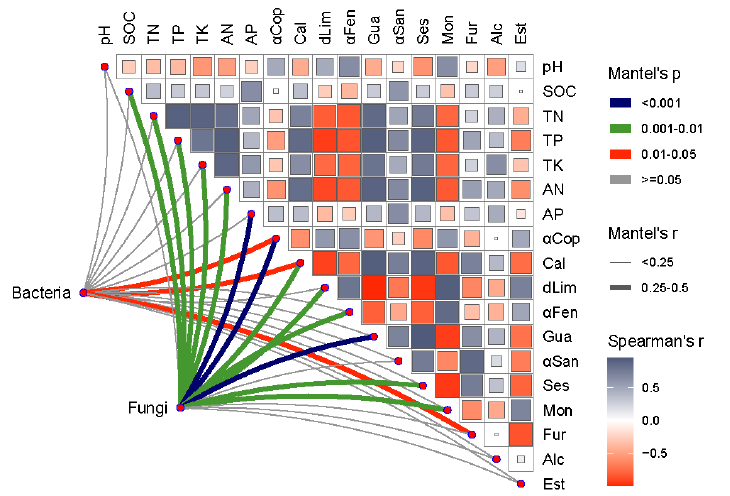
Figure 5. Soil physiochemical and root-exudate-related drivers of the soil bacterial and fungal community compositions. Soil microbial community composition was correlated to soil variables by partial Mantel tests based on the Bray – Curtis distance. Pairwise comparisons of soil physiochemical properties and root exudates are shown at the upper-right, with a color gradient representing Spear- man’s correlation coefficients. The edge width represents the partial Mantel’s r statistic for the cor- responding correlation, and the edge color denotes that significance was tested based on 999 per- mutations. SOC, soil organic carbon; TN, soil total nitrogen; TP, soil total phosphorus; TK, soil total potassium; AN, soil available nitrogen; AP, soil available phosphoru s; αCop, α -Copaene; Cal, Ca- larene; dLim, D- Limonene; aFen, α - Fenchene; Gua, Guaiol; aSan, α -Santalene; Ses, sesquiterpenes; Mon, monoterpenes; Fur, furan; Alc, alcohols; Est, esters.